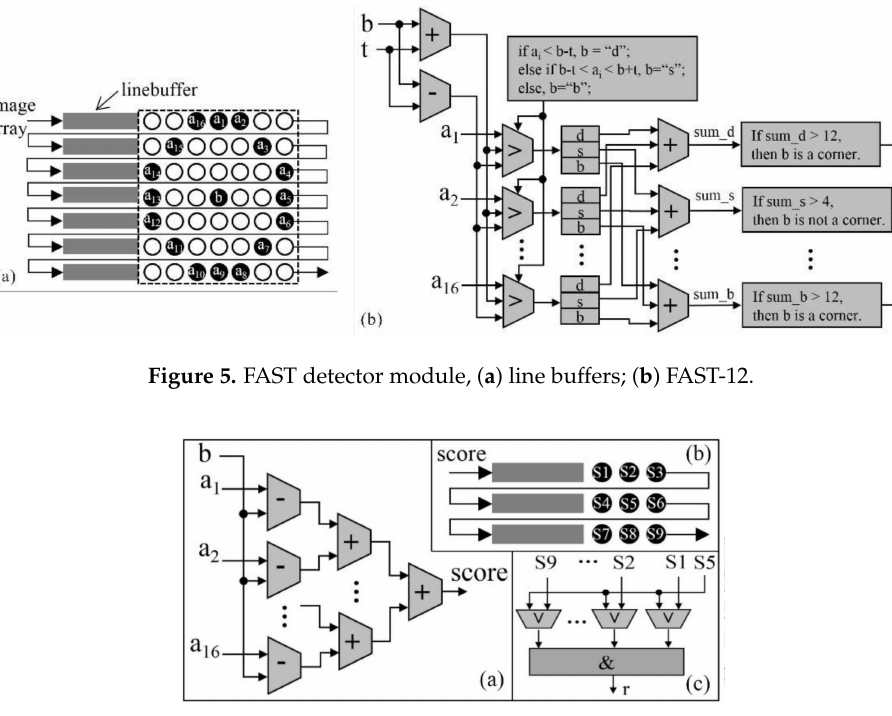
Figure 6. Robust corner selection module, ( a ) corner score; ( b ) line buffers; ( c ) non-maximum